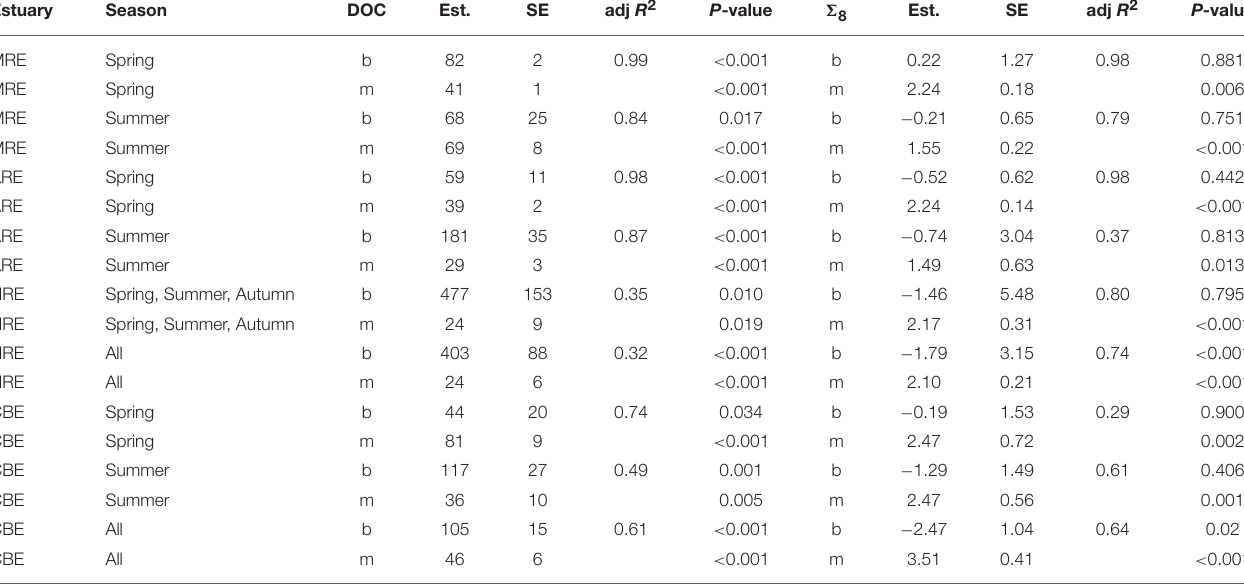
TABLE 3 | Parameter estimates (Est.) for linear regression models (DOC or 6 8 = m × a 350 + b).